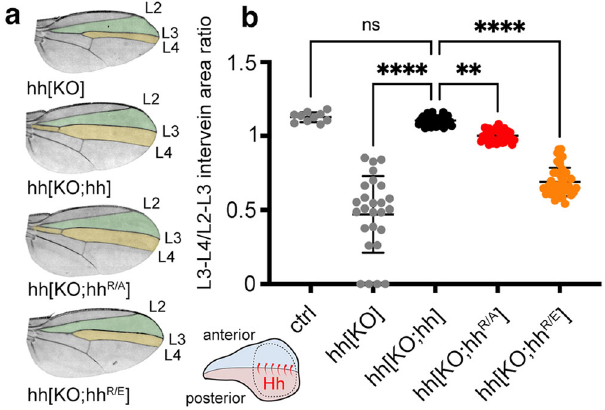
Fig. 4 | Substitution of HS-binding Hh amino acids affects Drosophila wing patterning. a Hh produced in clones of the posterior wing disc compartment (as showninthecartoon,Hhisproducedintheposteriorcompartmentofthediscand moves over a signi fi cant distance 35 to the anterior receiving compartment, Sup- plementary Fig. 5) directly patterns the central domain of the adult wing (orange). Wing patterning beyond the central domain (the green area and the anterior top space that is not colored) depends on Dpp expression. Note that wing- mispatterning phenotypes are similar if due to the lack of Hh production in wing disc clones homozygous for hh[KO] or if homozygous for hh[KO;hh R/E ]. Clonal hh expression, in contrast, completely restored wing patterning. b Quanti fi cation of wing phenotypes as shown in ( a ). Wings of female fl ies developing at 25°C were analyzed, and Hh function during development was expressed as L3-L4/L2-L3 intervein area ratios. Error bars represent standard deviation. Statistical sig- ni fi cance was determined by one-way ANOVA followed by Dunnett ’ s multiple comparison test, F =152. n =10 ( hh ), n =26 (hh[KO]), n =39 (hh[KO;hh]), n =34 (hh[KO;hh R/A ]), and n =43 (hh[KO;hh R/E ]). **** p ≤ 0.0001, ** p =0.0019, ns: p =0.96. Source data are provided as a Source Data fi le. No sex bias was observed in any assay. Ctrl: FRT82B donor